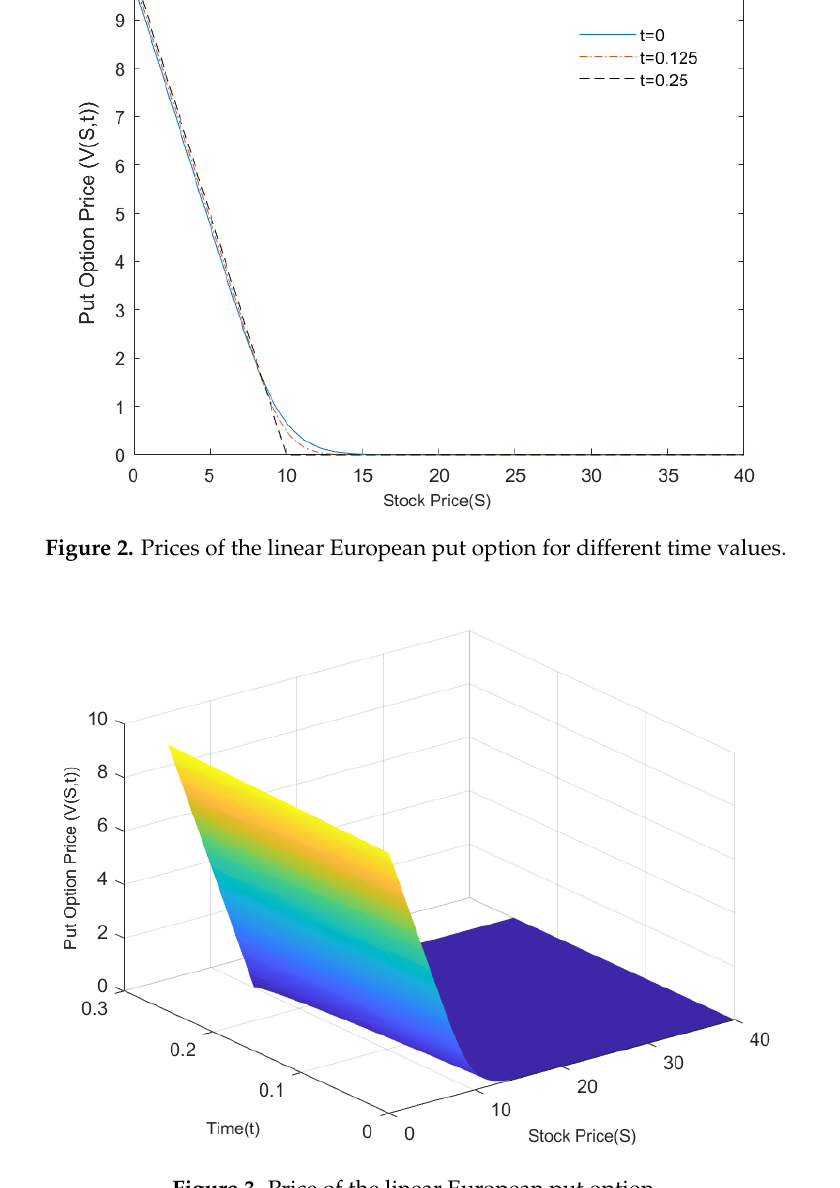
Figure 3. Price of the linear European put